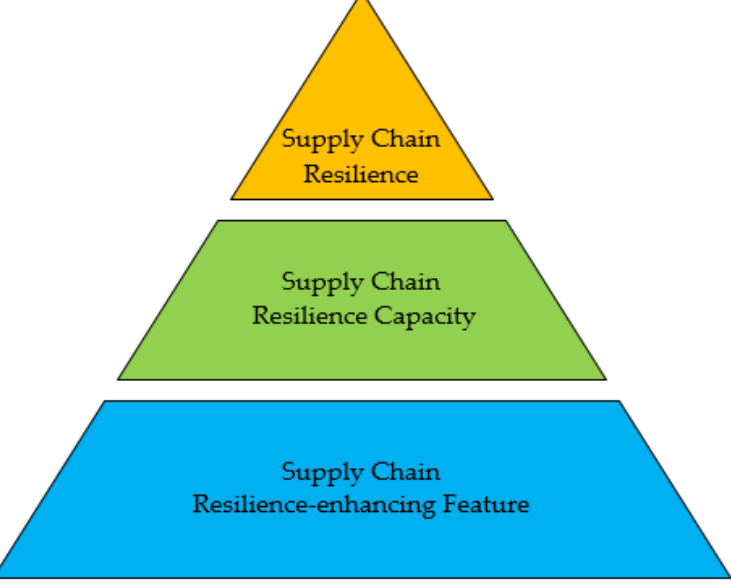
Figure 1. The hierarchy for supply chain resilience (Modified from [9]).